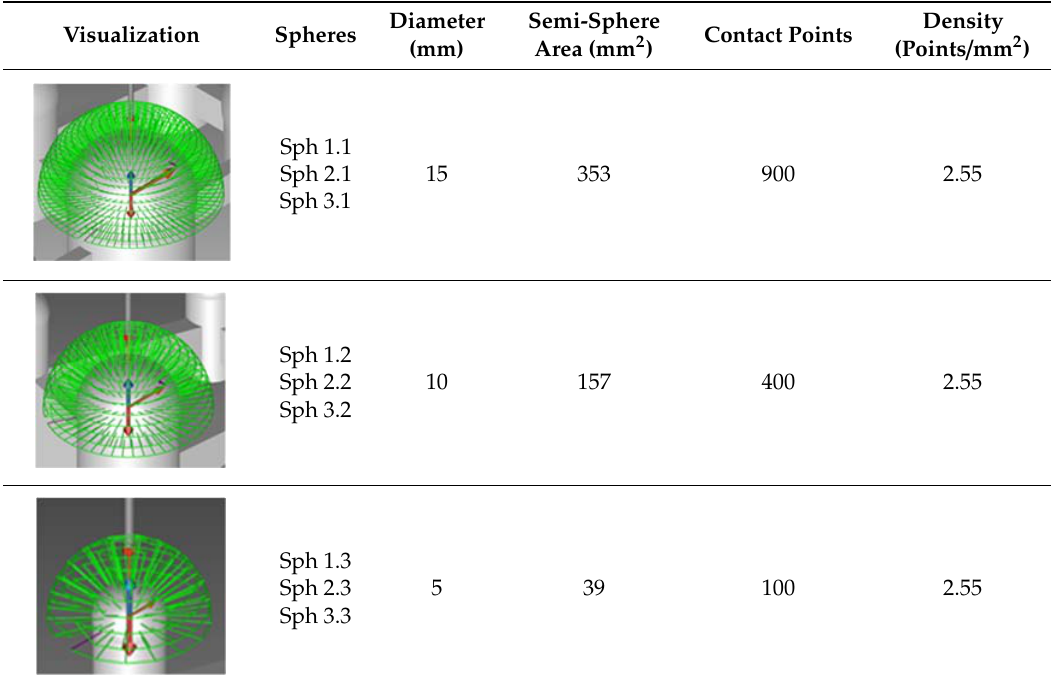
Table 1. Contact measurement parameters depending on the sphere diameter.